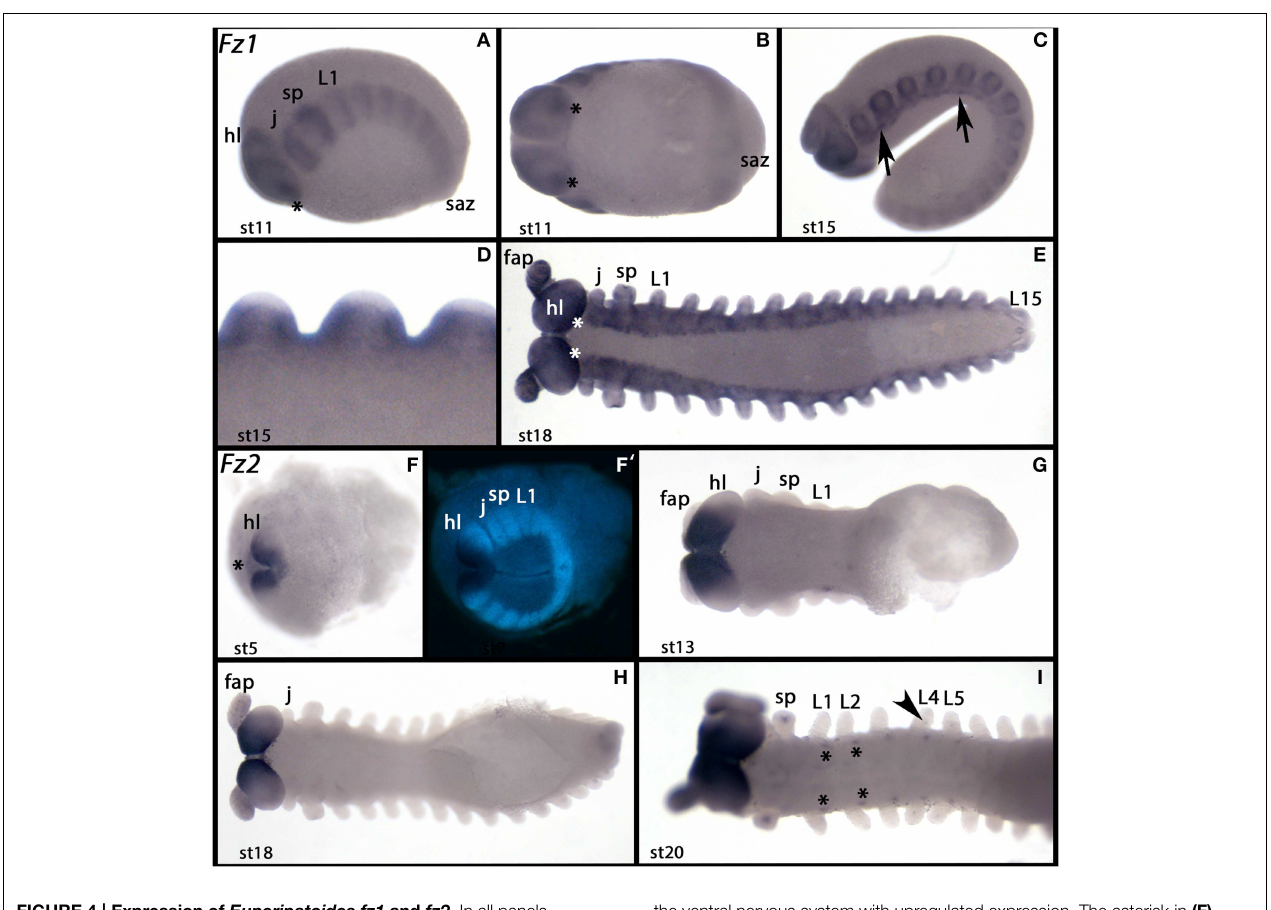
FIGURE 4 | Expression of Euperipatoides fz1 and fz2. In all panels anterior is to the left. (A–E) Show expression of Ek-fz1. (F–I) Show expression of Ek-fz2 . (A,C) Lateral views. (B,E–I) Ventral views. (D) Dorsal view. (F ′ ) Shows the DAPI counterstaining of the embryo shown in (F) (same position). Developmental stages are indicated. Asterisks in (A,B,E) mark expression at the posterior rim of the head lobes. Arrows in (C) point to clusters of cells in